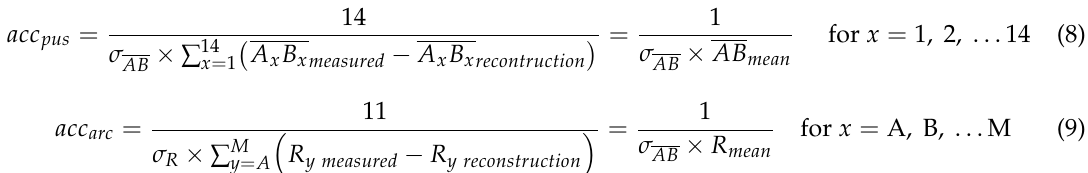
Table 5. Error in mean distances and its standard deviations in cm in the 20 surface reconstructions. Acq. Grid